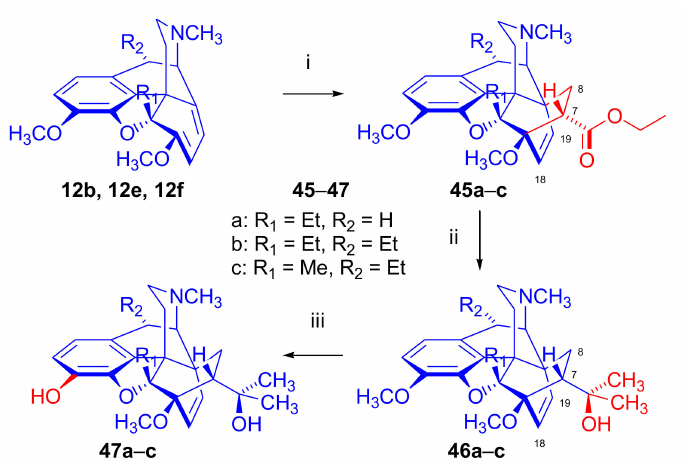
Figure 15. Synthesis of 5 β - and 10 α -substituted 20-methylorvinol derivatives. Reagents and conditions : (i): ethyl acrylate, (ii): methylmagnesium bromide, and (iii): KOH, diethylene